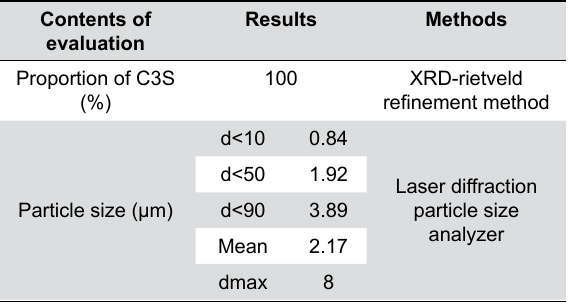
Table 1- Characteristics of prepared cement powder. "d<n" is defined as the diameter at which n% of the sample's cumulative